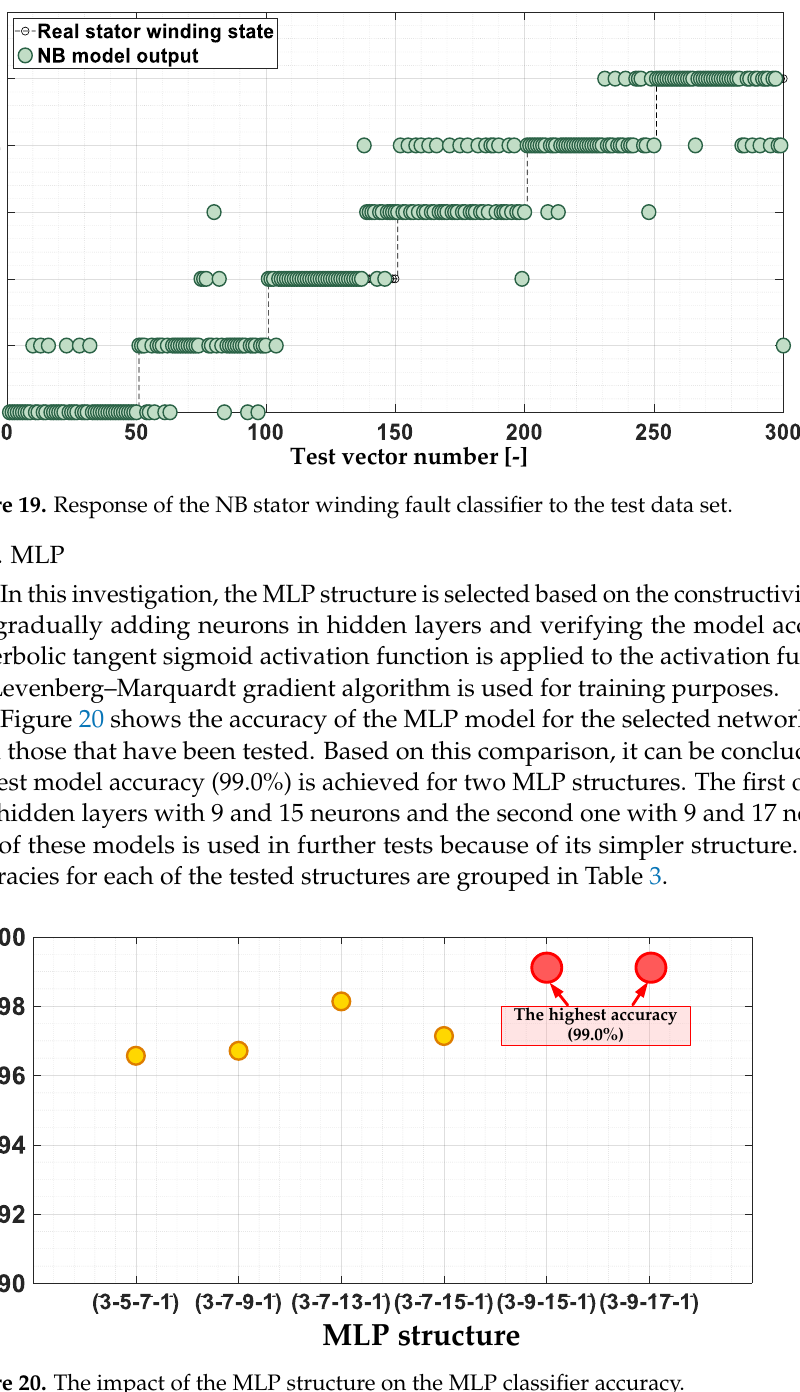
19 of 28 Figure 18. The impact of the NB type on the NB classifier accuracy. Table 2. The NB classifier accuracy for different conditional probability. NB Classifier Type Accuracy GNB 74.7% KNB (Triangle) 76.3% KNB (Box) 78.9% KNB (Epanechnikov)